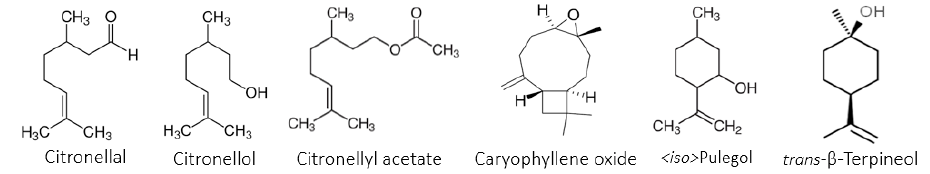
Figure 2. Major compounds of essential oils of E. sideroxylon .